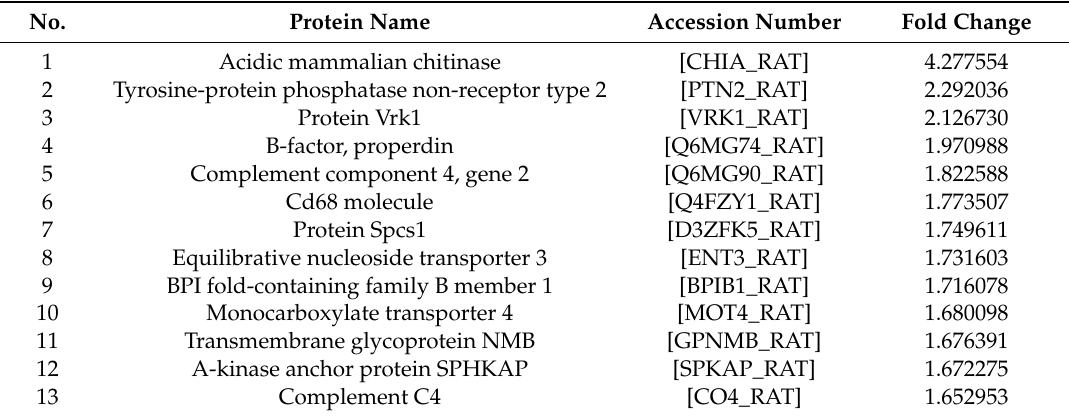
Table 1. Subset of di ff erentially expressed proteins in silicotic rat lung tissue relative to the controls. No. Protein